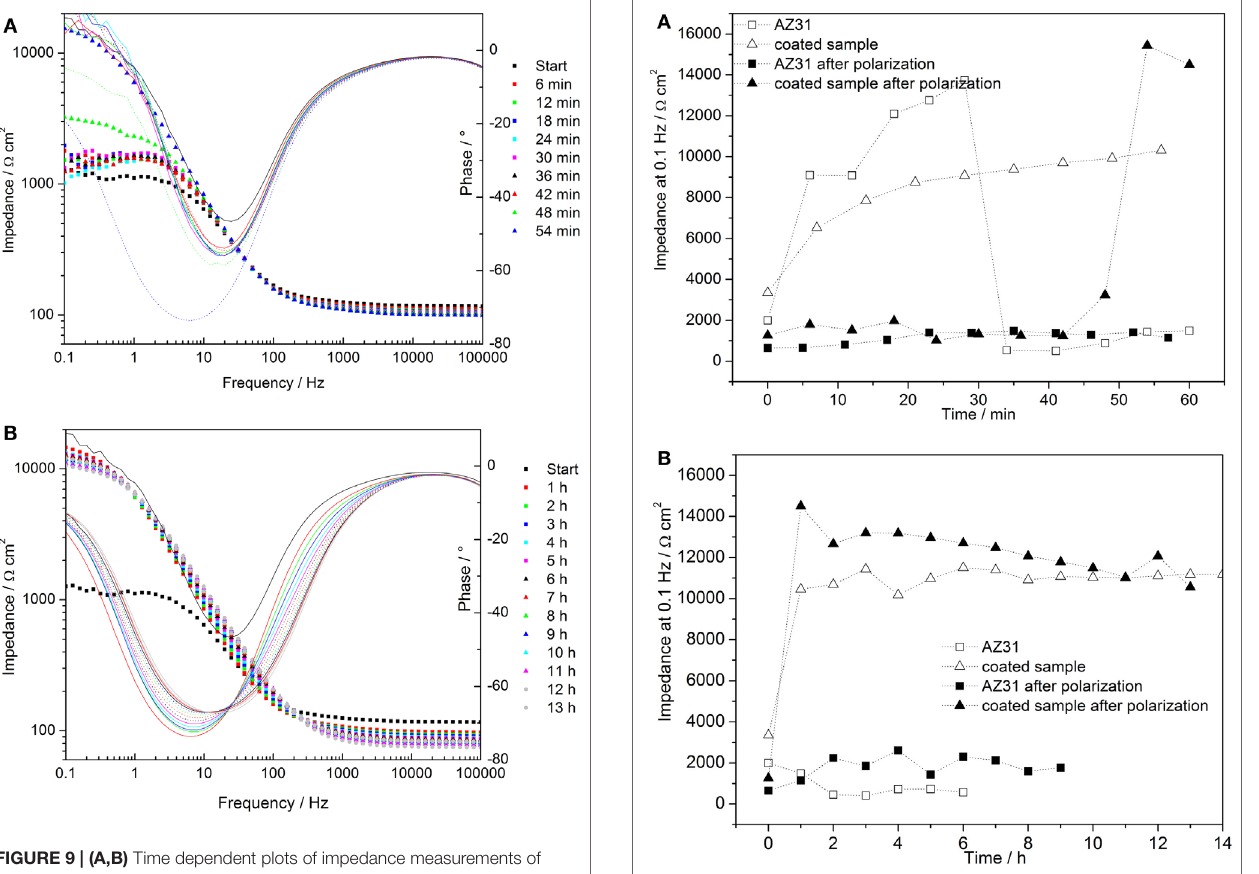
FigUre 10 | (a,B) Time-dependent evolution of pore resistance of coated sample after 1 h of polarization of 0.5 V vs. Eoc (a) development during first hour after and (B) hourly